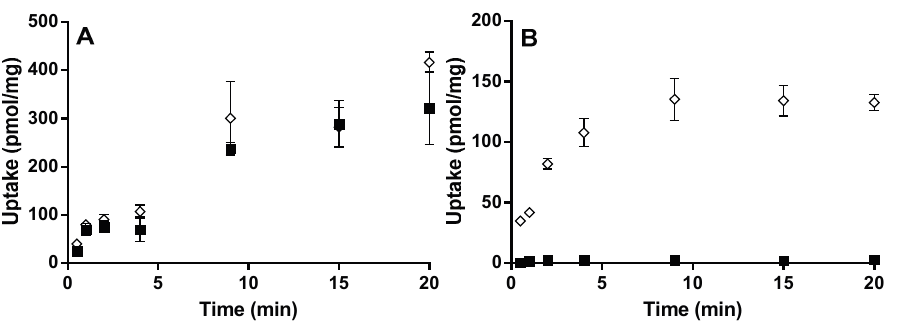
Figure 2. Time-dependent uptake of ( A ) 1 µM montelukast and ( B ) 0.5 µM E 1 3S at pH 7.4